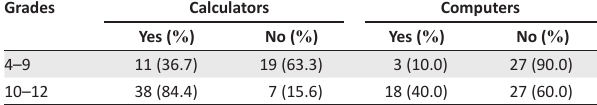
TABLE 3: The use of calculators and computers by grade.